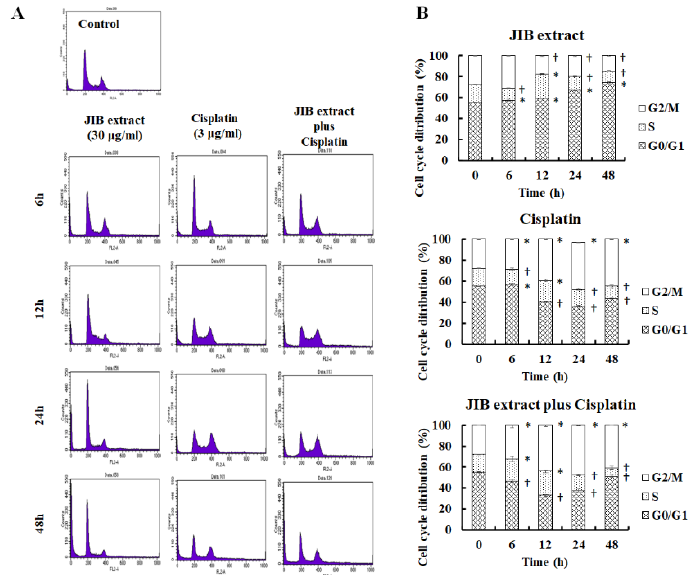
Figure 3. Cell cycle distribution of OECM ‐ 1 cells after treatment with JIB extract plus cisplatin. A total of 2 × 10 6 OECM ‐ 1 were seeded in 10 cm dishes and treated with JIB extract (30 μ g/mL) and cisplatin (3 μ g/mL) for 6, 12, 24 and 48 h. After the cells were collected, the cell cycle was analyzed by flow cytometry, and cell cycle progression was observed. ( A ) Image showing the cell cycle distribution; ( B ) quantitative cell cycle data. *—significantly increased compared with the control; † —significantly decreased compared with the control. ( p < 0.05).